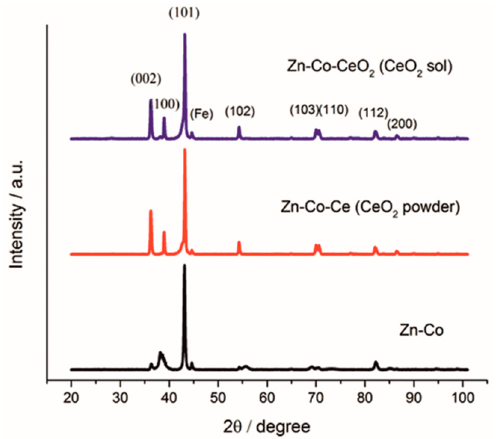
Figure 9. XRD pattern of Zn-Co, Zn-Co-CeO 2 (CeO 2 powder) and Zn-Co-CeO 2 (CeO 2 sol) coatings.